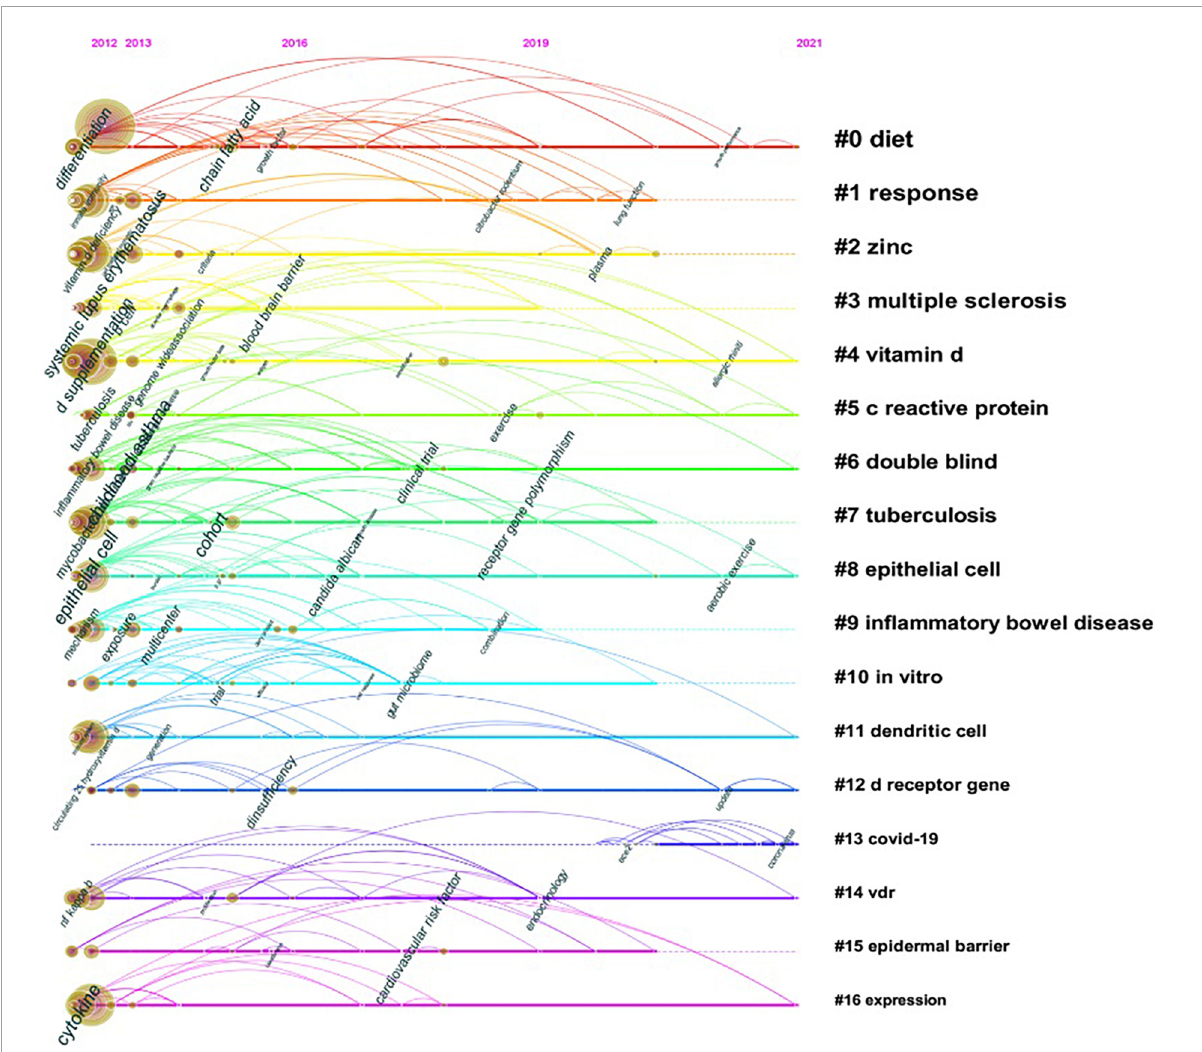
FIGURE6 Timeline view of keyword cluster. Timeline maps are used to show the evolution of research hotspots in a time-based manner. The length of the horizontal straight line of a cluster indicates its time